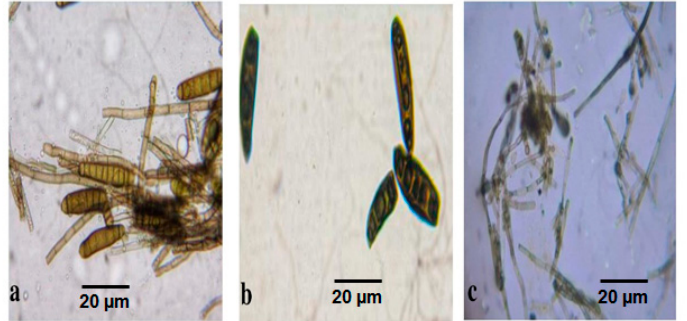
Figure 2. Morphological characteristics of endophytic fungi. Microscopic aspect of hyphae and spores of endophyte isolated from ( a ) Graminicolous helminthosporium , ( b ) Bipolaris australiensis , and ( c ) Cladosporium cladosporioides . Scale bars = 20 µm.